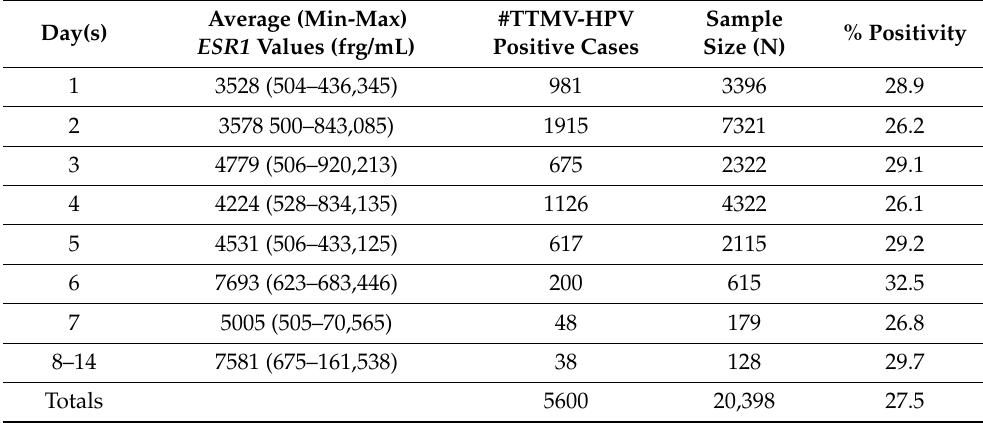
Table 1. Stability of TTMV-HPV DNA analyte detection in blood measured by percent positivity. ESR1 values are given in fragments per milliliter of plasma (frg/mL).